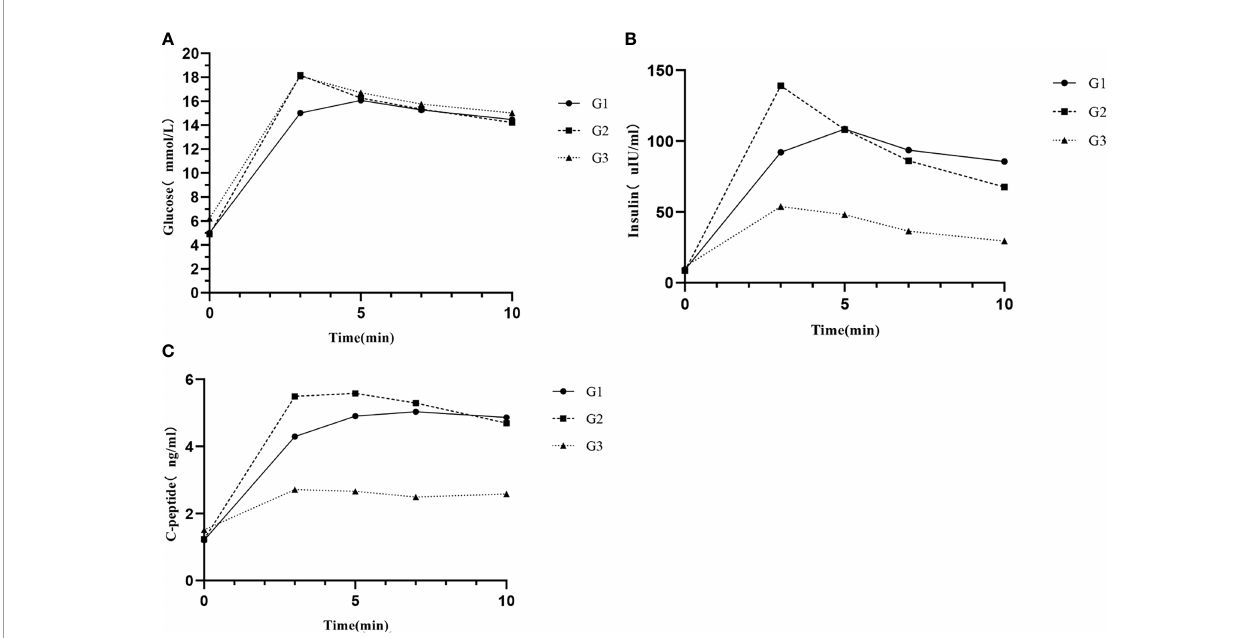
FIGURE 1 | (A) Glucose responses, (B) insulin responses, and (C) C-peptide responses during IVGTT among different groups. G1, subjects with normal glucose tolerance (NGT) and time to glucose peak after 3 min; G2, subjects with NGT and time to glucose peak at 3 min; and G3, subjects with prediabetes or diabetes mellitus and time to glucose peak at 3 min.